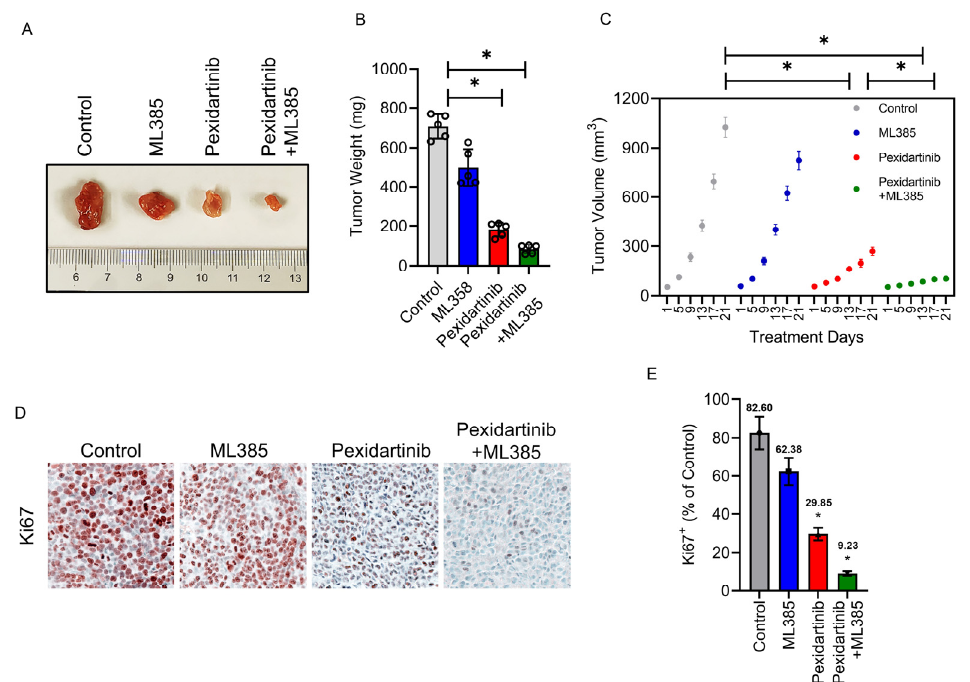
Figure 6. Pexidartinib inhibits ATC proliferation in vivo. ( A ) Images of CAL-62 xenografts after administration of pexidartinib or co-administration of pexidartinib with ML385 ( n = 5). ( B ) The tumor weights at the end of the treatment ( n = 5). ( C ) Tumor volume-time curves for xenografts for the treatment period ( n = 5). ( D ) IHC of Ki67 staining in xenografts. ( E ) Statistical analysis of Ki67 positive cells in xenografts. Data are presented as mean ± SD in at least three independent experi ‐ ments (significance is presented as * when p < 0.05).